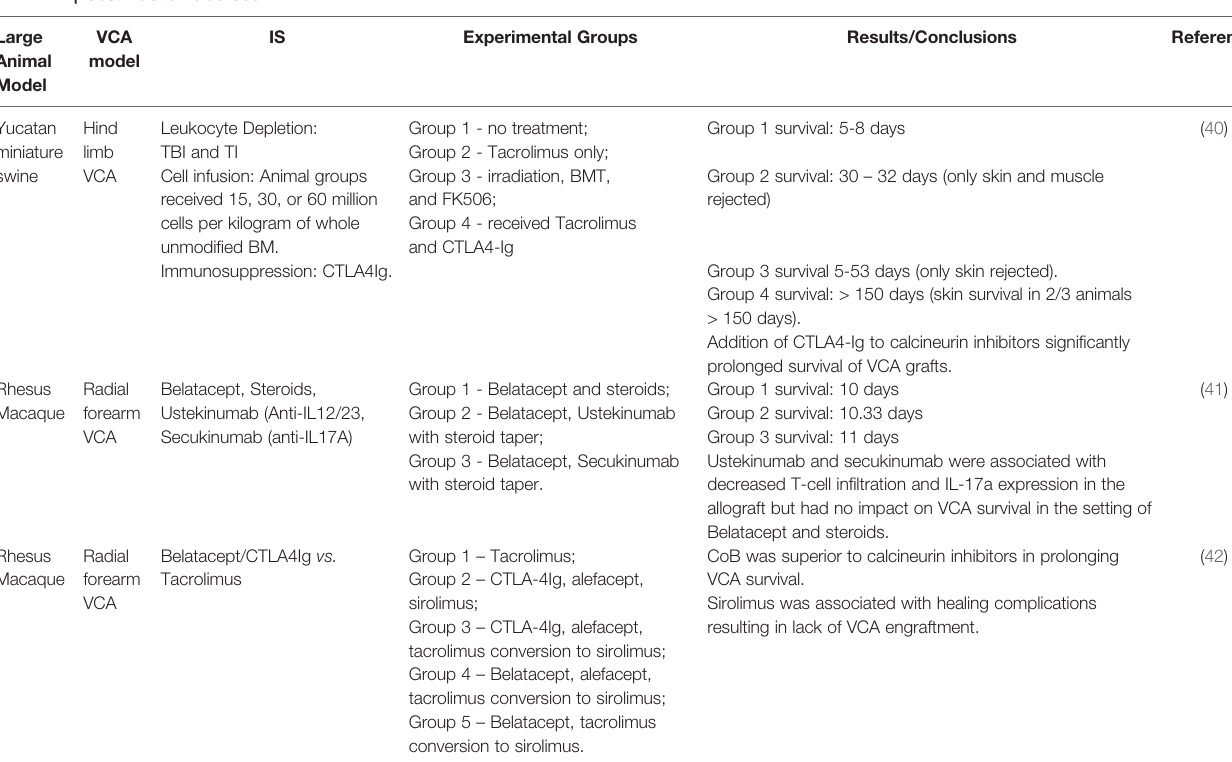
TABLE 2 | Costimulation